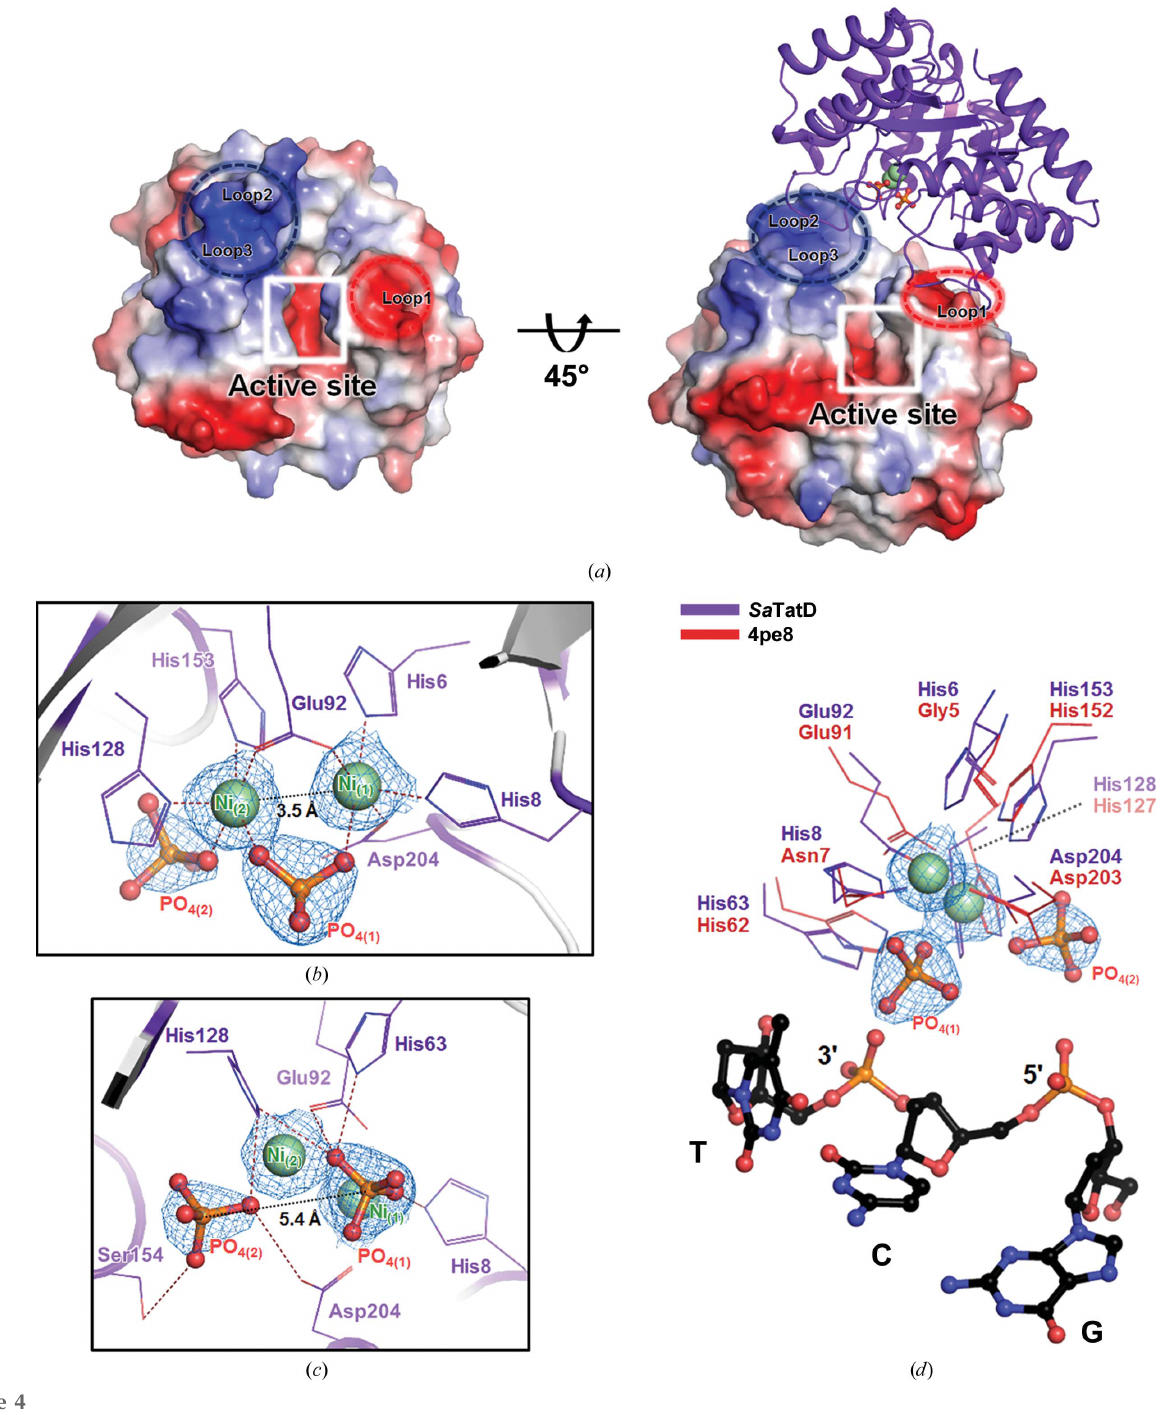
Figure 4 The active site of Sa TatD. ( a ) Electrostatic surface potential view of Sa TatD. The acidic active-site pocket is marked with a white box, and basic (blue) and acidic (red) surfaces composed of Loop2–Loop3 and Loop1, respectively, are marked in dotted circles. ( b ) Metal-binding site of Sa TatD. The key residues and two phosphates coordinating Ni 2+ ions are labeled and shown as lines and in ball-and-stick representation, respectively. The interactions are shown as red dotted lines. The distance between the Ni 2+ ions is labeled and is shown as a black dotted line. ( c ) The key residues contributing to the binding of phosphates are labeled and shown as lines. The distance between the P atoms of the phosphates is labeled and is shown as a black dotted line. ( d ) Superimposed view of Sa TatD and the E. coli TatD–DNA complex (PDB entry 4pe8), revealing that the two phosphates of Sa TatD resemble the scissile phosphates of DNA in E. coli TatD. T, thymine; C, cytosine; G, guanine. In ( b – d ), 2 mF o (cid:3) DF c electron-density maps contoured at 2.0 (cid:6) are shown as a blue